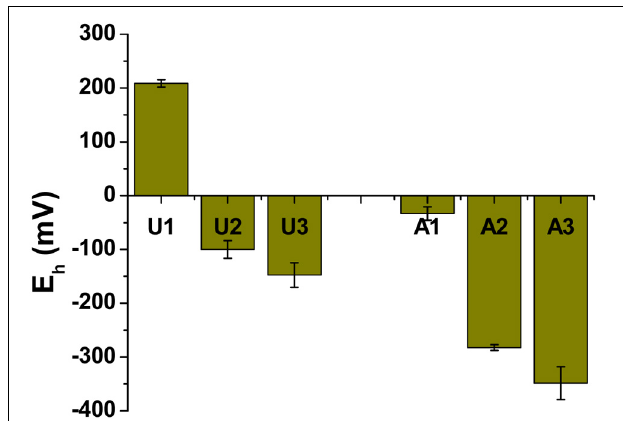
FIGURE 2 | Redox potential (E h ) in unamended (U) and amended (A) MFT. Measurements were taken from port 1 (cap water; see Figure 1 in Siddique et al., 2014) and ports 2 and 3 (solids) after 213 days incubation. Bars represent the mean values from analyses of triplicate samples taken from each column and error bars represent 1 standard deviation.